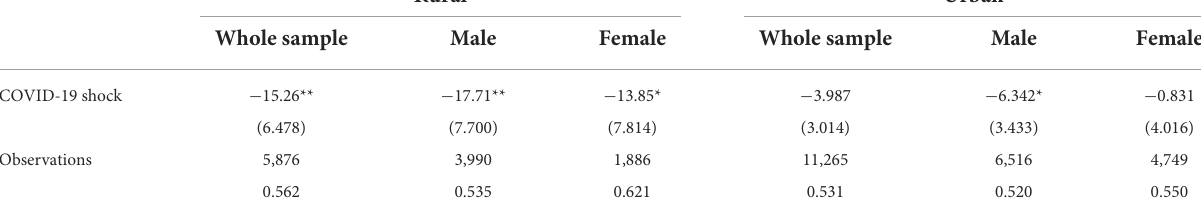
TABLE 11 Heterogeneous analysis of